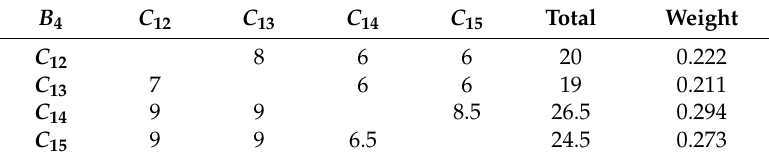
Table A5. Judgment matrix of C 12 – C 15 .